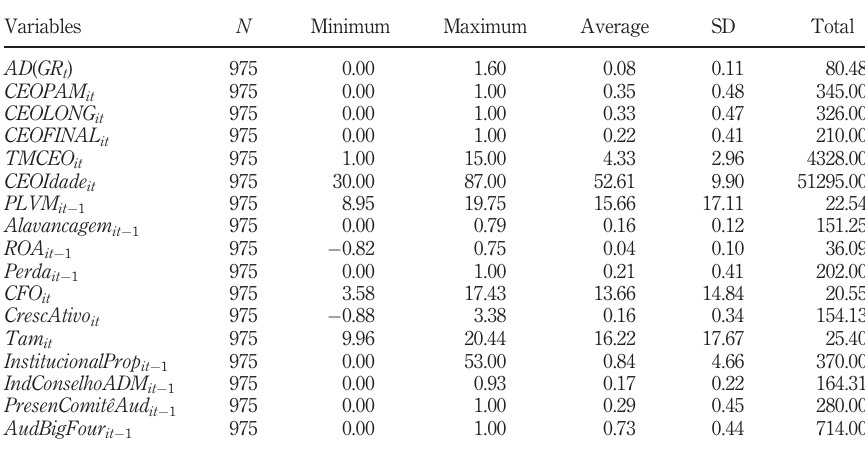
Table I. Descriptive statistics of the studied